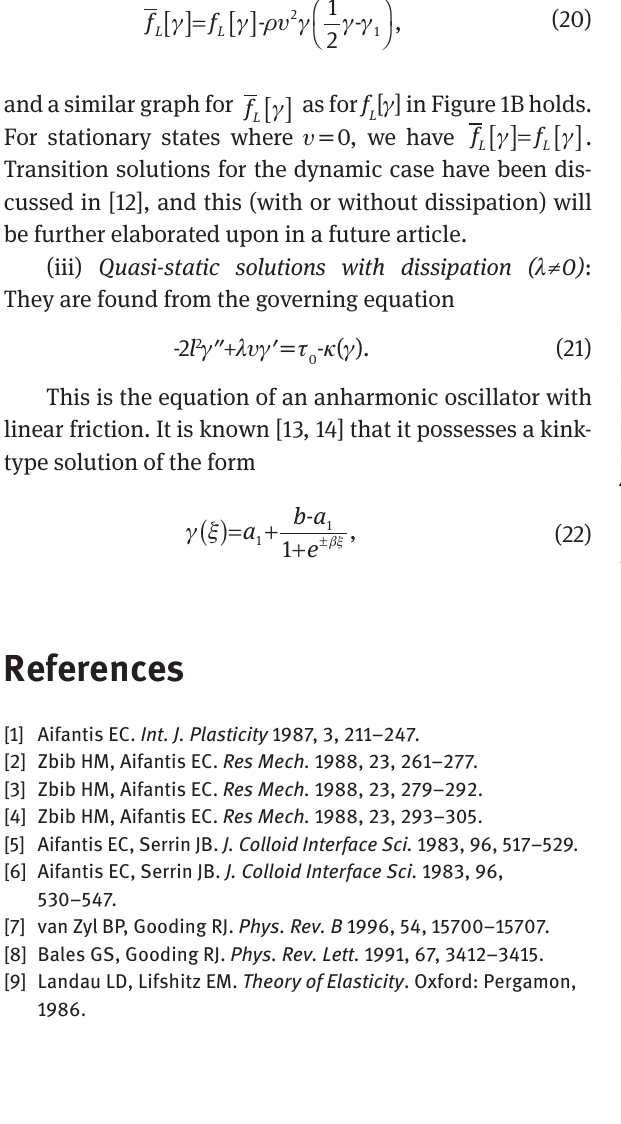
where of the following cubic equation